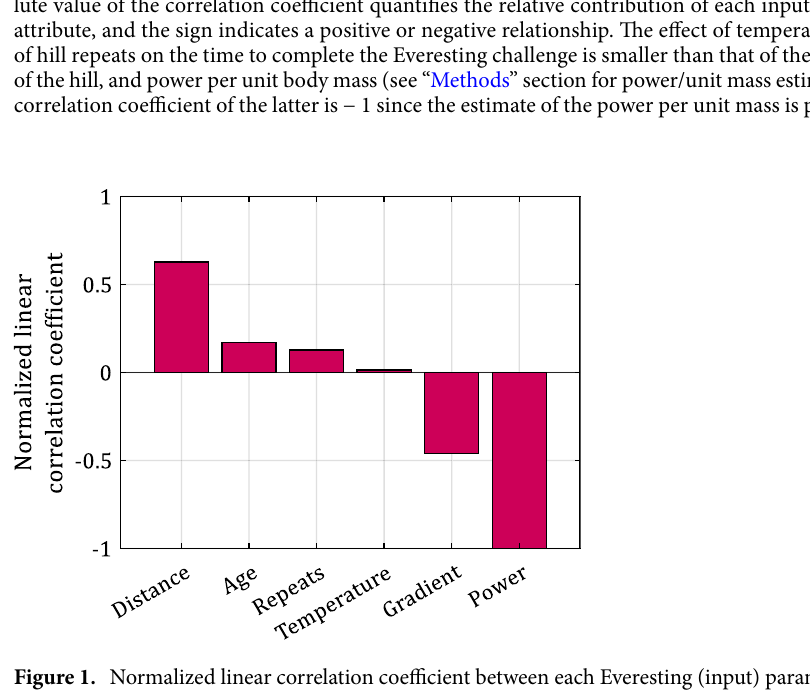
Figure 1. Normalized linear correlation coefficient between each Everesting (input) parameter and time (target attribute) to complete the Everesting challenge, showing that power, distance, and gradient are the main factors that determine